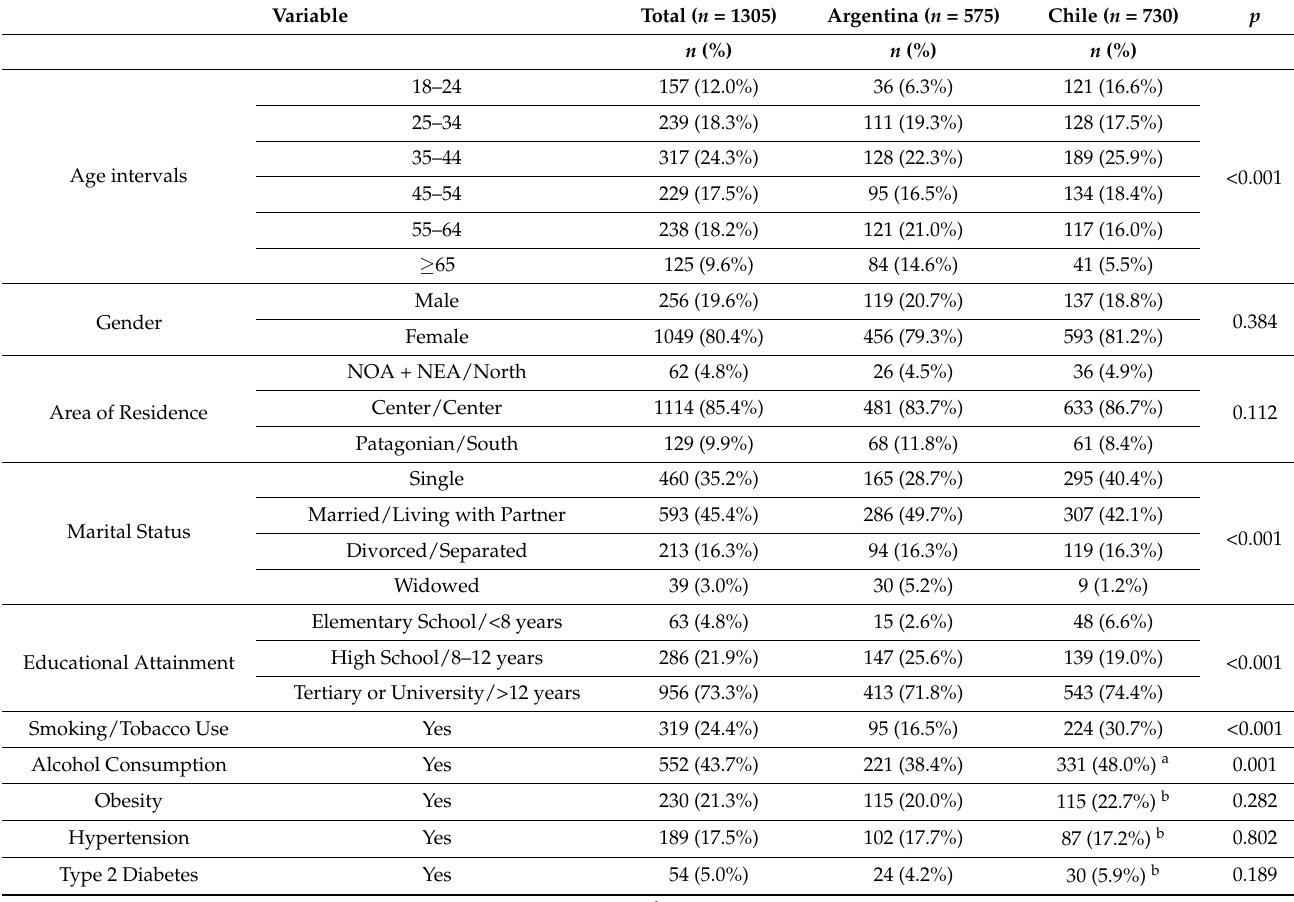
Table 1. Descriptive characteristics of the overall sample and by country.